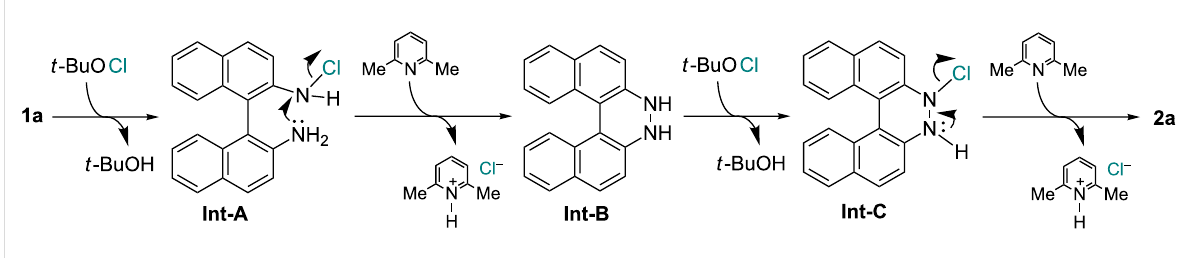
Scheme 5: A possible reaction pathway of the oxidative ring-closure of 1a .